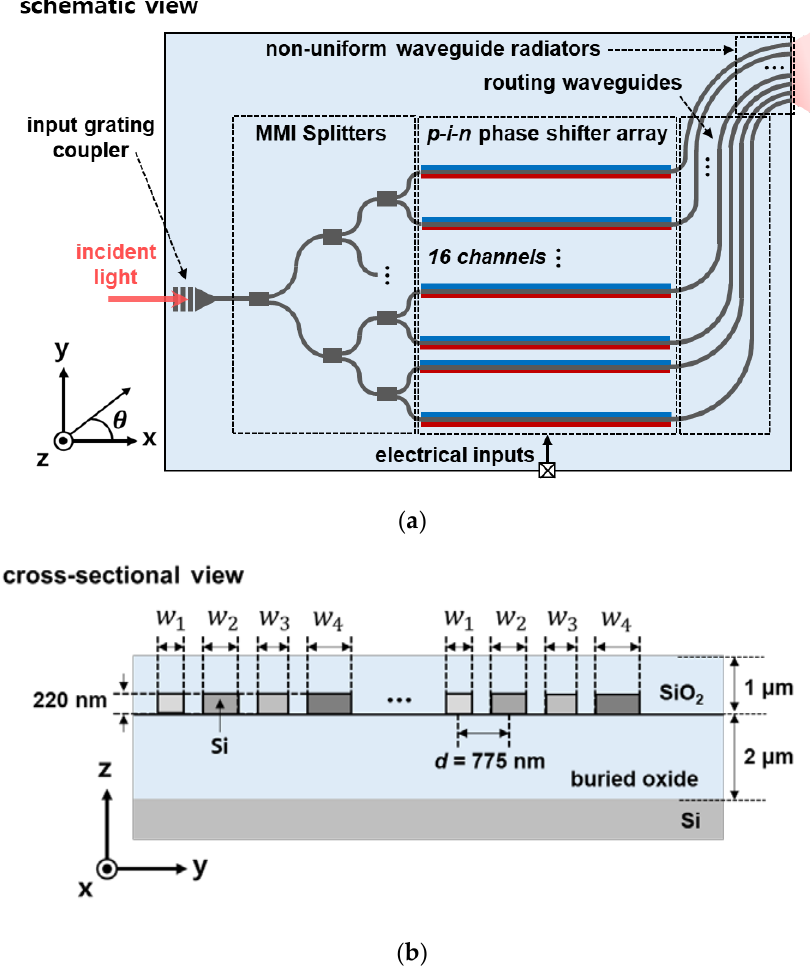
Figure 1. ( a ) Schematic view of the designed optical phased array (OPA); ( b ) cross-sectional view of the non-uniform waveguide